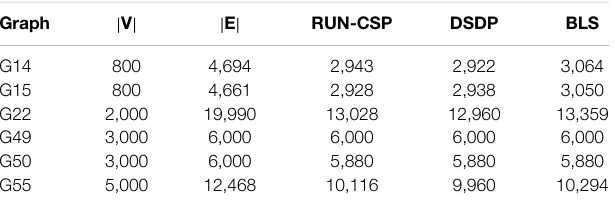
TABLE 4 | M AX -C UT : Achieved cut sizes on Optsicom Benchmarks. The optimal valueswereestimatedbyKhaliletal.,(2017)byrunningCPLEXfor1 honeach